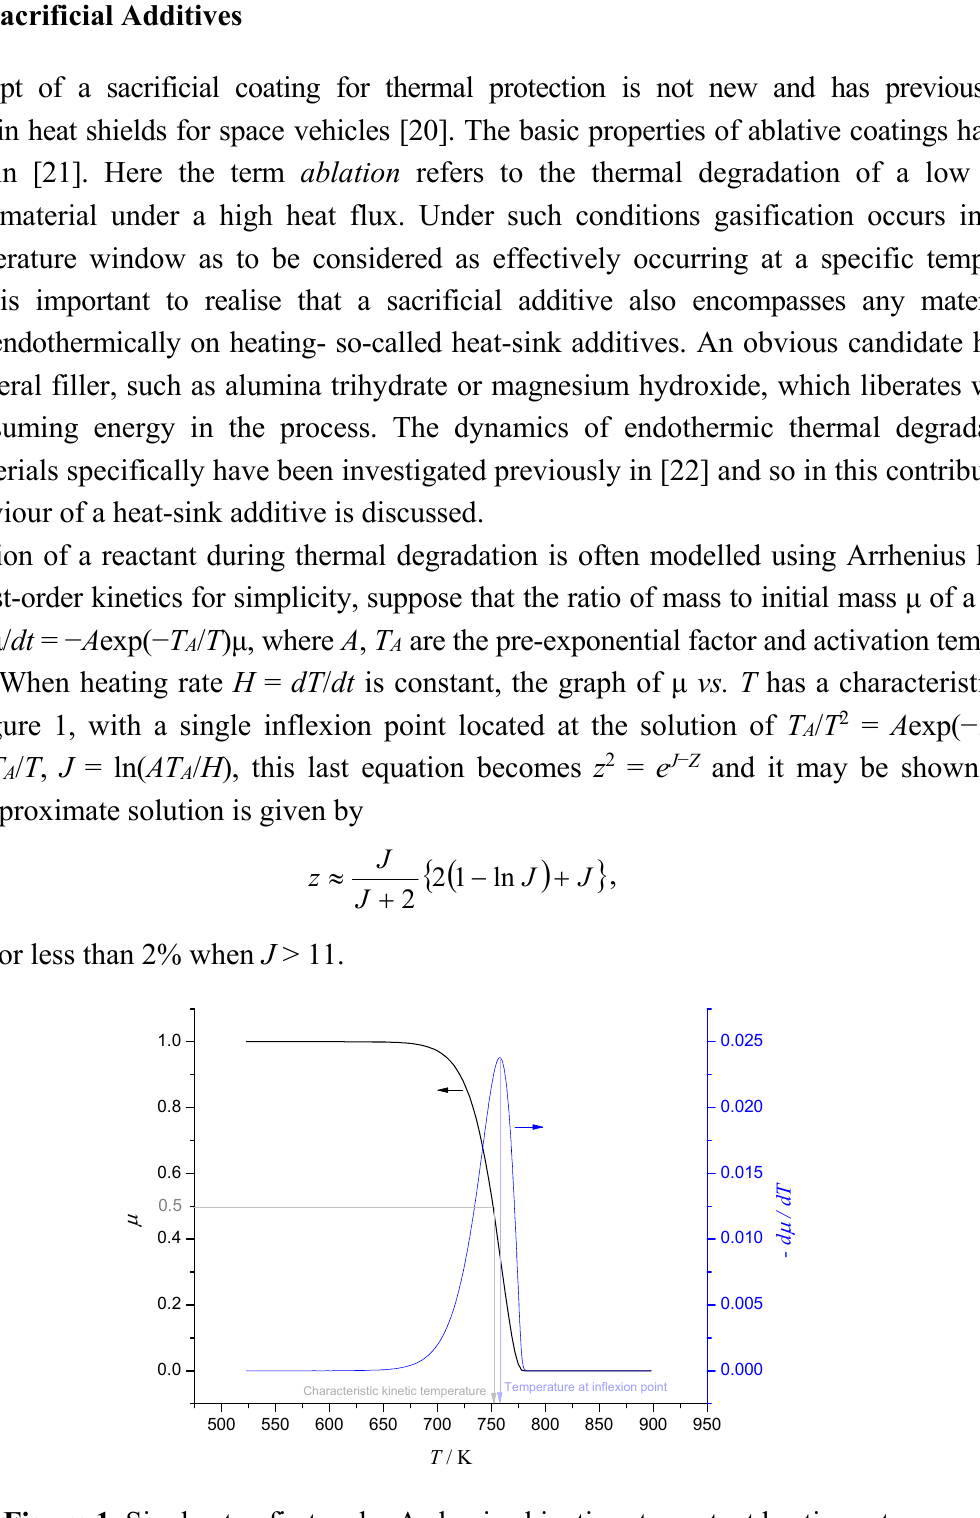
Figure 1. Single-step first-order Arrhenius kinetics at constant heating